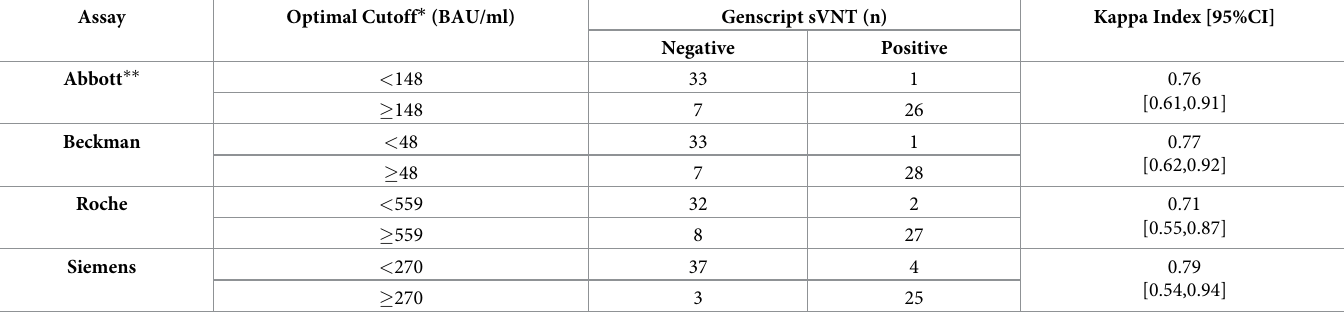
Table 3. Agreement between antibody binding assays and Genscript sVNT positive and negative results according to optimal cutoff values determined for each assay.